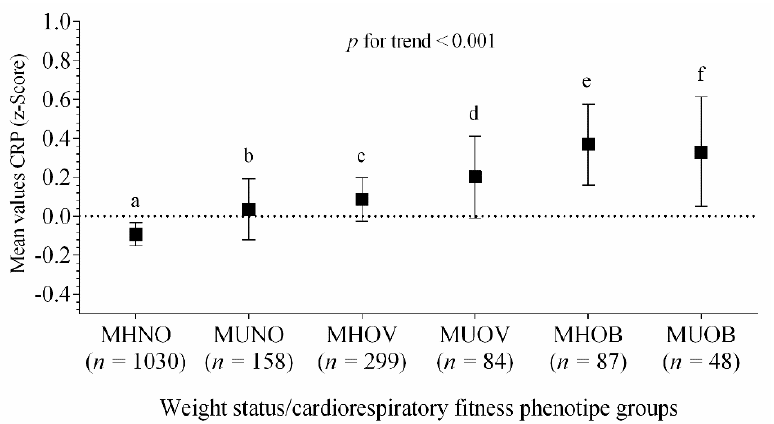
Figure 2. Di ff erences in the means values of high-sensitive CRP Z-score across metabolic phenotypes of weight status. Bars represent adjusted means and 95% confidence intervals, for age, sex, pubertal stage and country, as confounders. The dashed line represents a value of zero for the scores, and a higher score represents greater high-sensitive CRP levels. Di ff erences ( (cid:44) ) between groups, after Bonferroni adjustment, a (cid:44) (c, d, e, f); b (cid:44) (e, f); c (cid:44) (a, e); ( p < 0.04 for all). Metabolically healthy non-overweight (MHNO); metabolically unhealthy non-overweight (MUNO); metabolically healthy overweight (MHOV); metabolically unhealthy overweight (MUOV); metabolically healthy obese (MHOB); and metabolically unhealthy obese